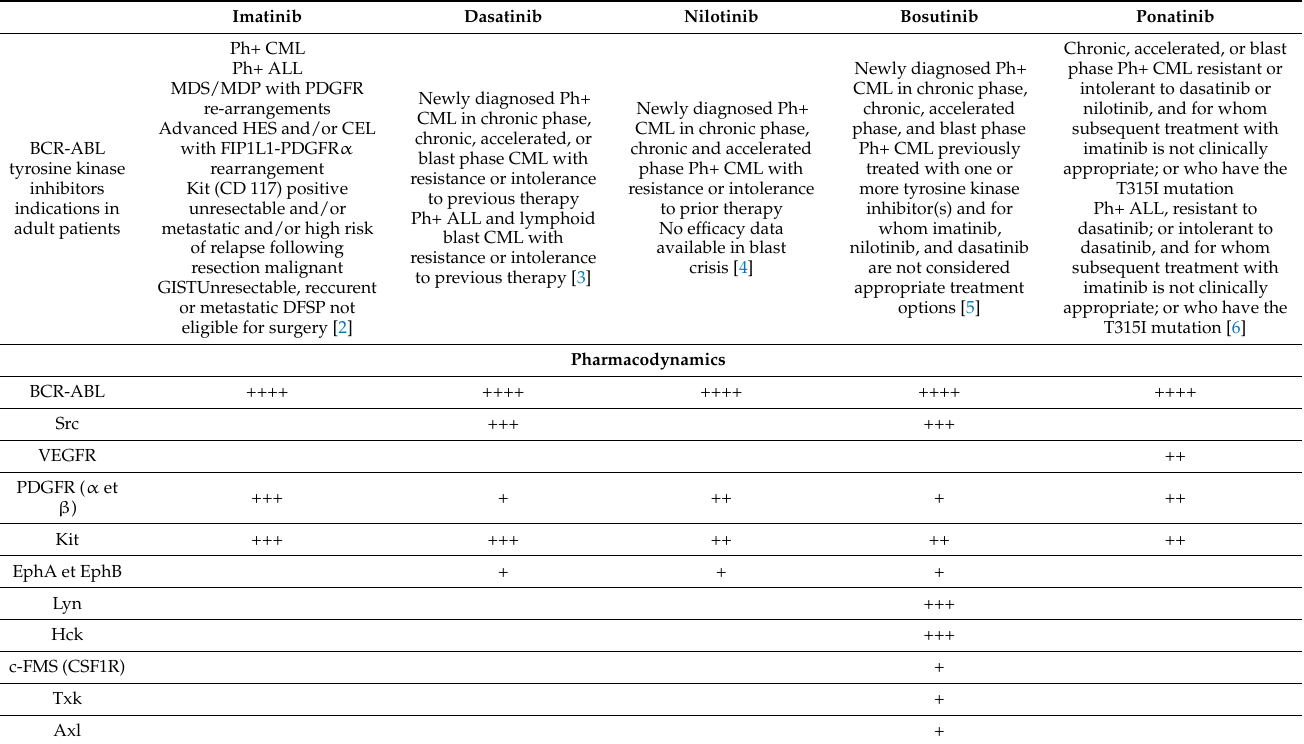
Table A1. Market authorizations as well as pharmacokinetic and pharmacodynamic characteristics of BCR-ABL tyrosine kinase